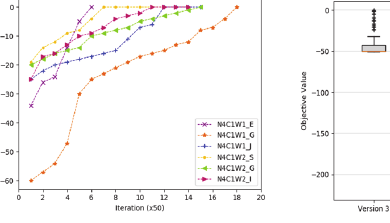
Fig. 13. Convergence of Version 3 Fig. 14. Performance comparison of Fig. 15. Performance comparison Fig. 16. Performance comparison HS variations of HS variations on input 2 of HS variations on input 3 Acceleration Rate (AR) of Version 4 for sample datasets with 500 objects Function evaluations (NFEs) Acceleration Rate (AR) of Dataset with 500 objects